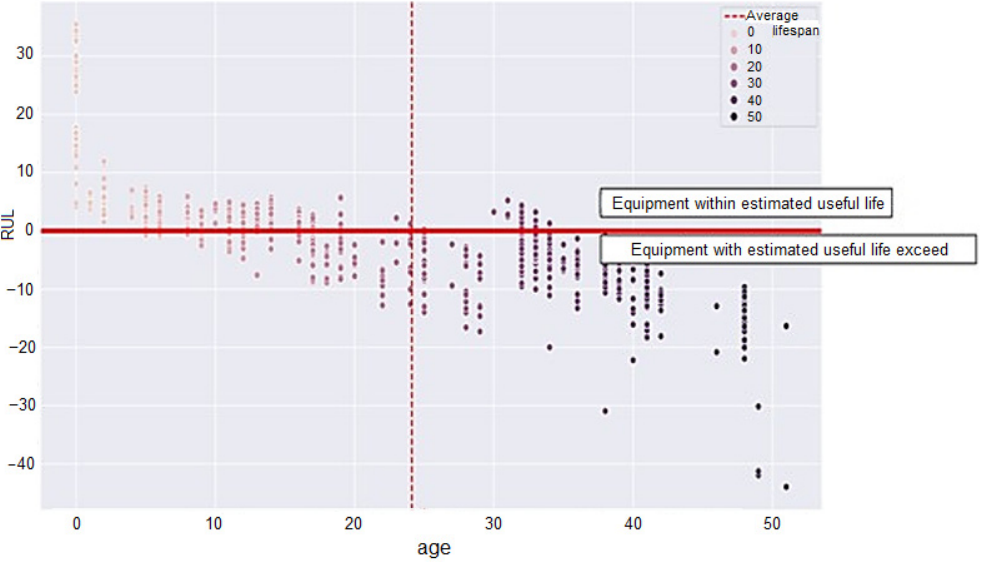
Figure 17. Relationship between the estimated useful life and the age of the equipment for RUT 340 [authors].